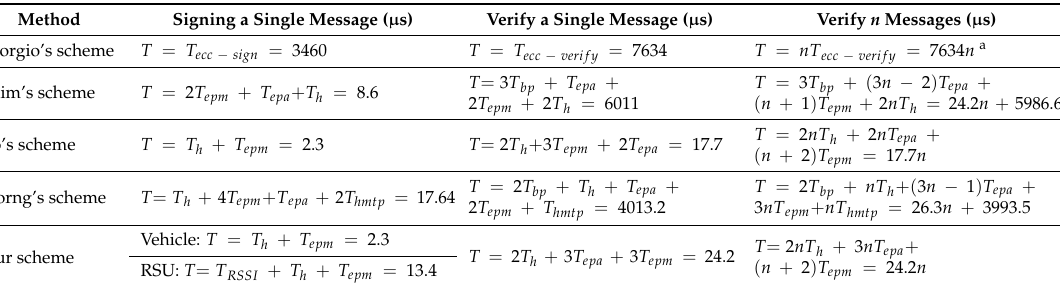
Table 4. Comparisons of the execution time of five